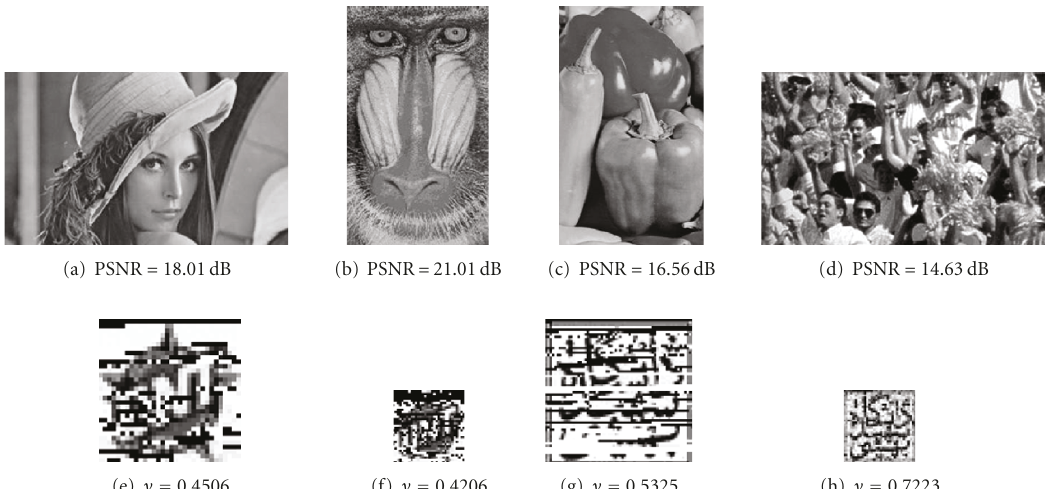
Figure 25: (a)–(d) the watermarked Lena, Baboon, Peppers and Crowd images after cropping, respectively. (e)–(h) the extracted watermarks from (a)–(d), respectively.